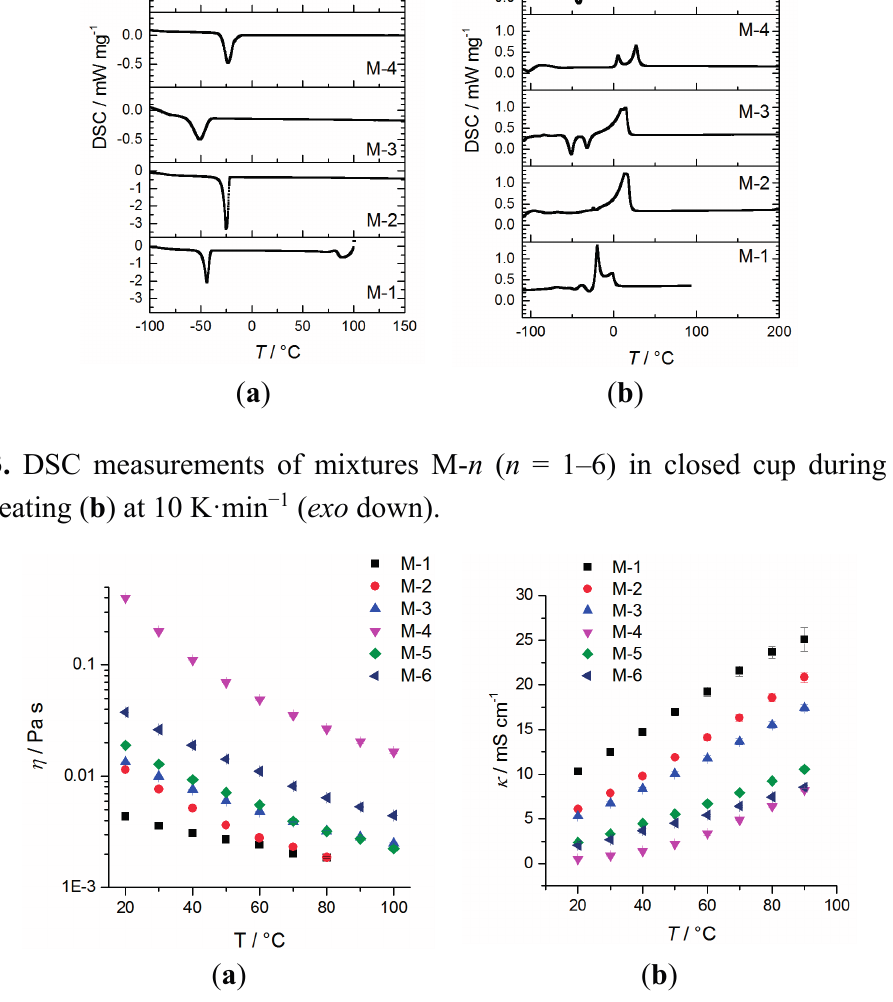
Figure 4. Temperature-dependent values of the viscosity ( a ) and conductivity ( b ) of mixtures M- n ( n = 1–6) between 20–100 °C (viscosity) and 20–90 °C (conductivity). See Table S3 for detailed